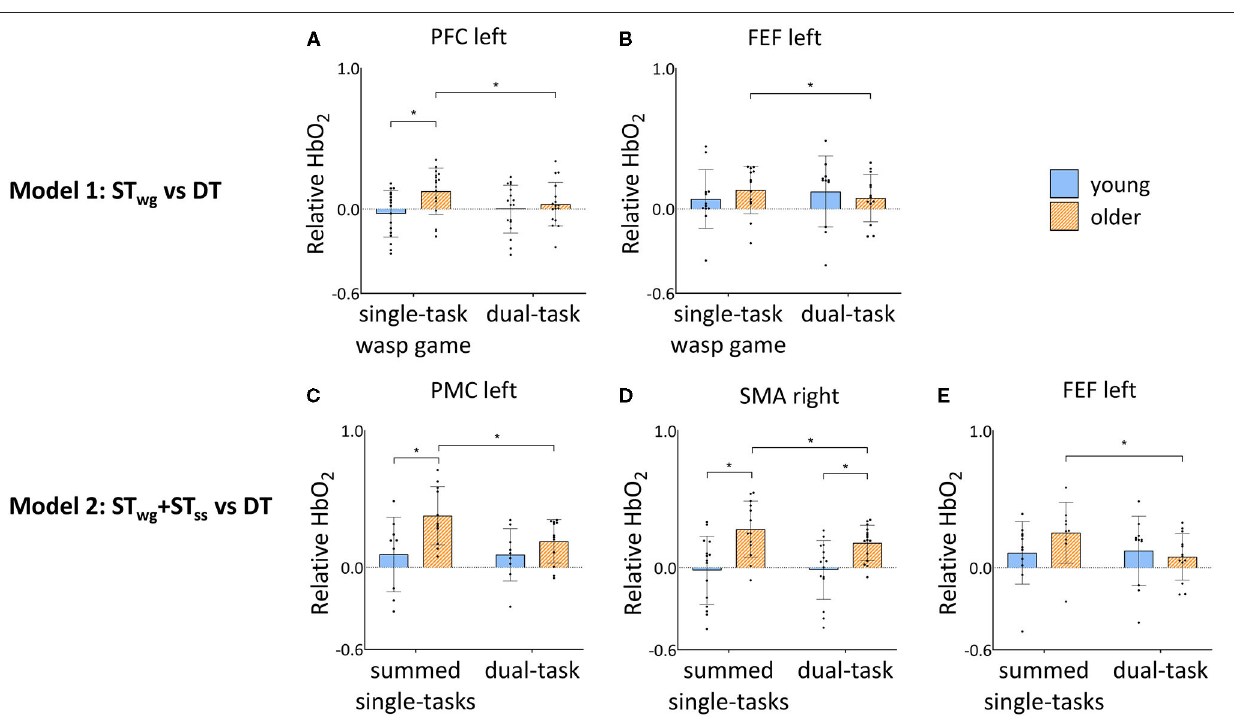
FIGURE 5 | Group by task interaction effects in PFC left (A) and FEF left (B) HbO 2 levels during ST wg and DT, and FEF left (C) , PMC left (D) and SMA right (E) HbO 2 levels during ST wg + ST ss and DT in young and older adults. HbO 2 levels are calculated relative to the baseline task and displayed as mean ± SD. Individual data points represent relative HbO 2 levels for each participant. *Significant post-hoc effects ( p < 0.05). ST wg , single-task wasp game; ST ss , single-task serial subtractions; DT, dual-task; PFC, pre-frontal cortex; FEF, frontal eye fields; PMC, premotor cortex; SMA, supplementary motor